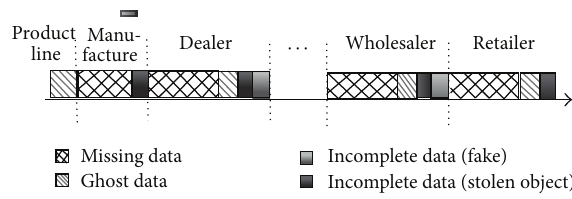
Figure 5: Appearance positions for ghost, missing, and incomplete data in supply